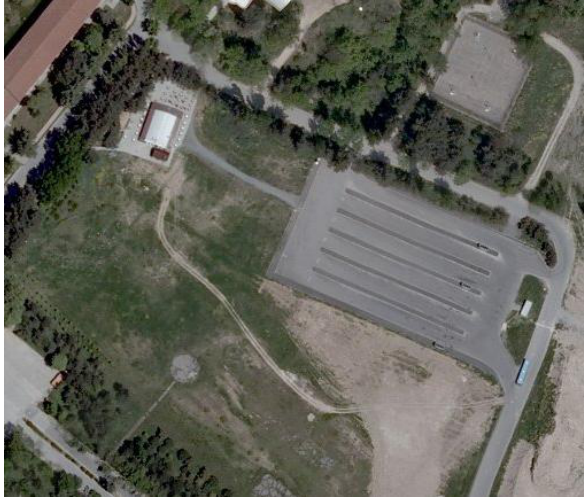
Figure 2. The overview of the test side in Davutpasa Campus of